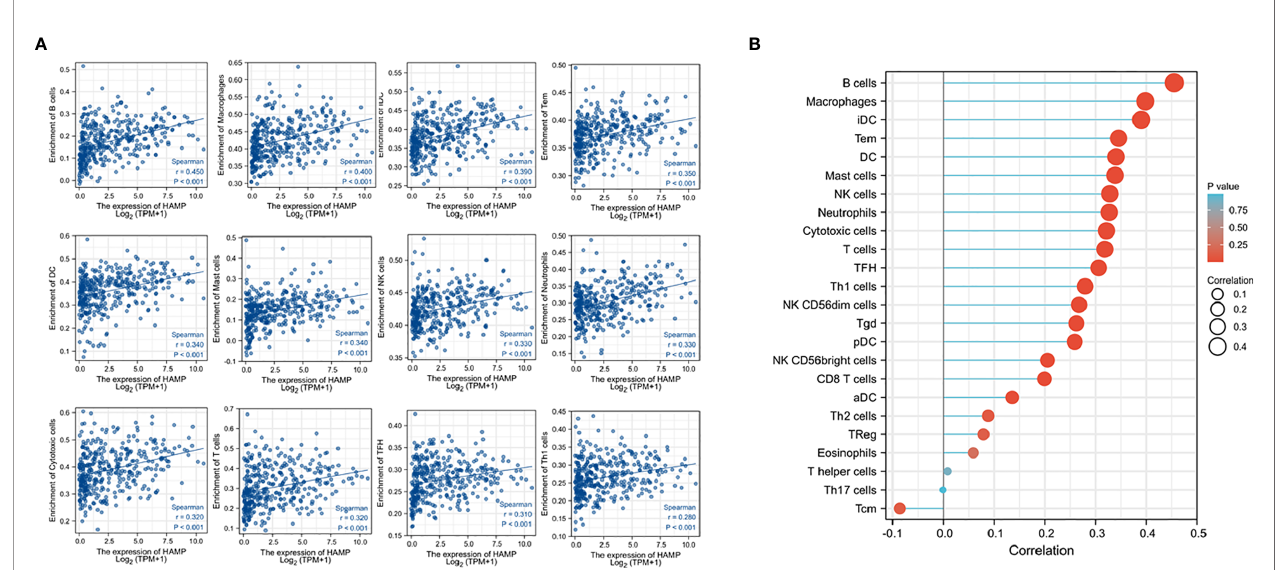
FIGURE 6 | Hepcidin expression positively correlates with anti-cancer immune in fi ltration. The correlation of hepcidin expression levels with the immune in fi ltration in liver cancer tissues was analyzed using the TCGA dataset on the XIANTAO platform (n = 424). Strong correlations (Spearman rho > 0.3) were shown from 11 immune types in (A) . (B) showed the correlations for all 24 immune cell types. iDC, immature DC; Tem, T effector memory; TFH, T follicular helper; Tgd, T gamma delta; pDC, plasmacytoid DC; aDC, activated DC; Tcm, T central